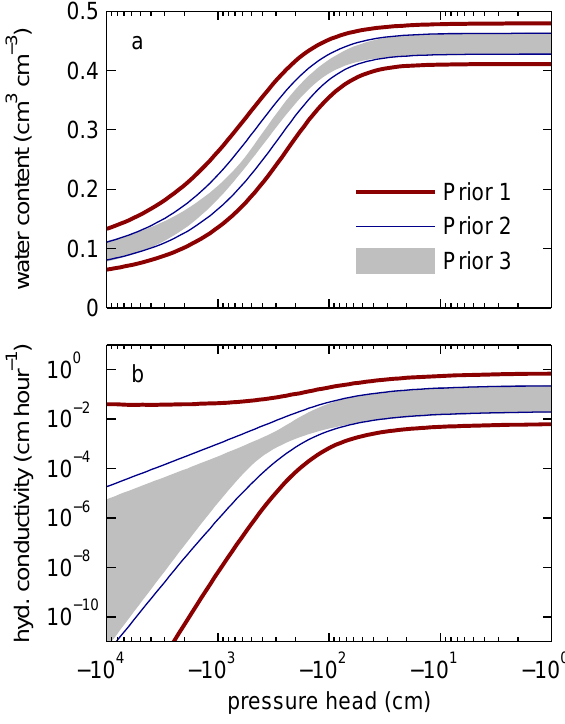
Fig. 2. 95% prior uncertainty bounds of (a) the water retention function and (b) the hydraulic conductivity function correspond- ing to the three prior probability distributions of the soil hydraulic parameters: multivariate uniform distribution (Prior 1), multivariate normal distribution without correlation among the soil hydraulic pa- rameters (Prior 2), and multivariate normal distribution with corre- lation among the soil hydraulic parameters (Prior